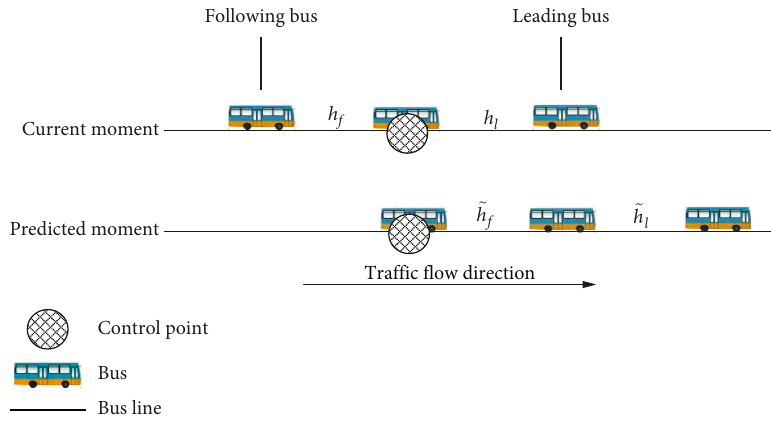
Figure 1: Prediction of step length in the coordinated control